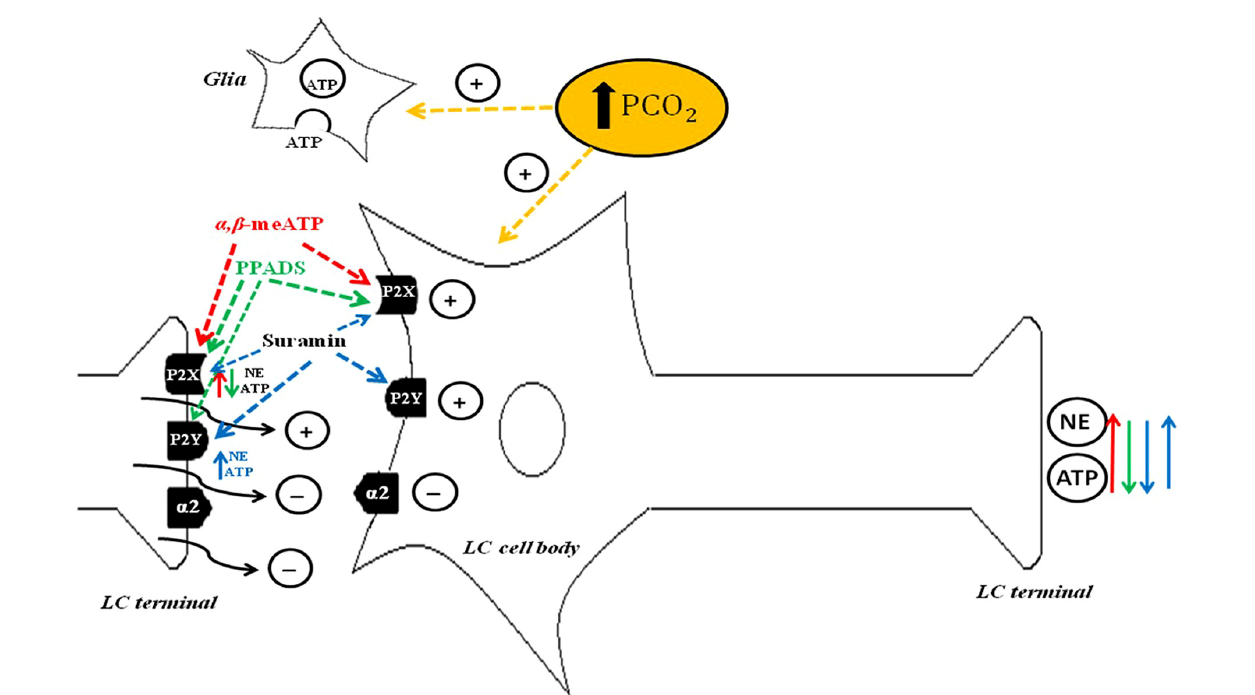
FIGURE 3 | Schematic drawing depicting possible mechanisms of purinergic signaling in the locus coeruleus (LC). ATP induces depolarization of noradrenergic neurons through P2X and P2Y postsynaptic receptors (Harms etal., 1992; Shen and North, 1993), NE and ATP release through P2X presynaptic receptors (Boehm, 1999) and inhibition of NE and ATP release through P2Y presynaptic receptors (von Kügelgen etal., 1994, 1995; Poelchen etal., 2001). α , β -meATP agonism of P2X presynaptic receptors may promote NE and ATP release, whereas agonism of P2X postsynaptic receptors may activate noradrenergic neurons to further increase NE and ATP release (red arrow, Nieber etal.,